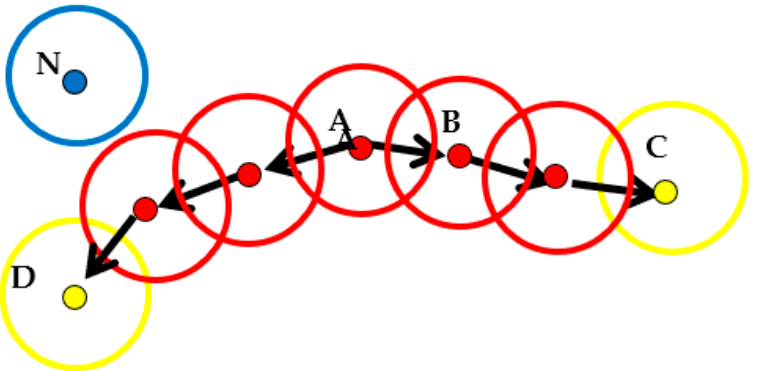
Figure 3. Schematic diagram of the DBSCAN clustering algorithm implementation. Where N is the noise (outlier) point, the circular solid line is the ε -neighborhood, A is the core object, B is directly reached by the density of A, C and D are reachable by the density of A, and the densities of C and D are connected.